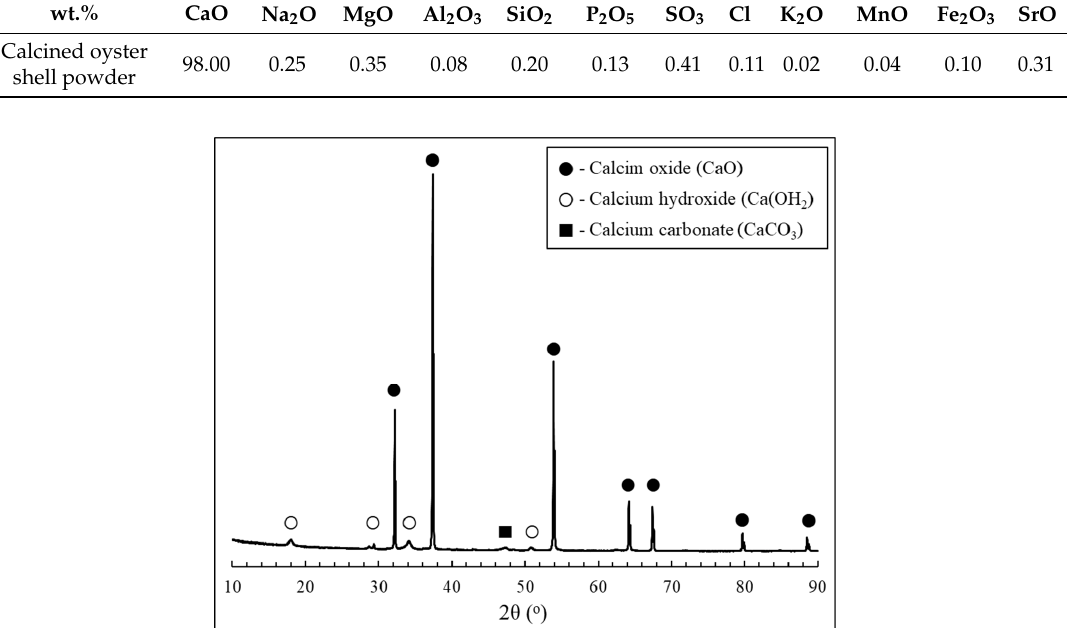
Table 1. Chemical compositions of calcined oyster shell powder measured with X-ray fluorescence (XRF) spectroscopy as weight %.